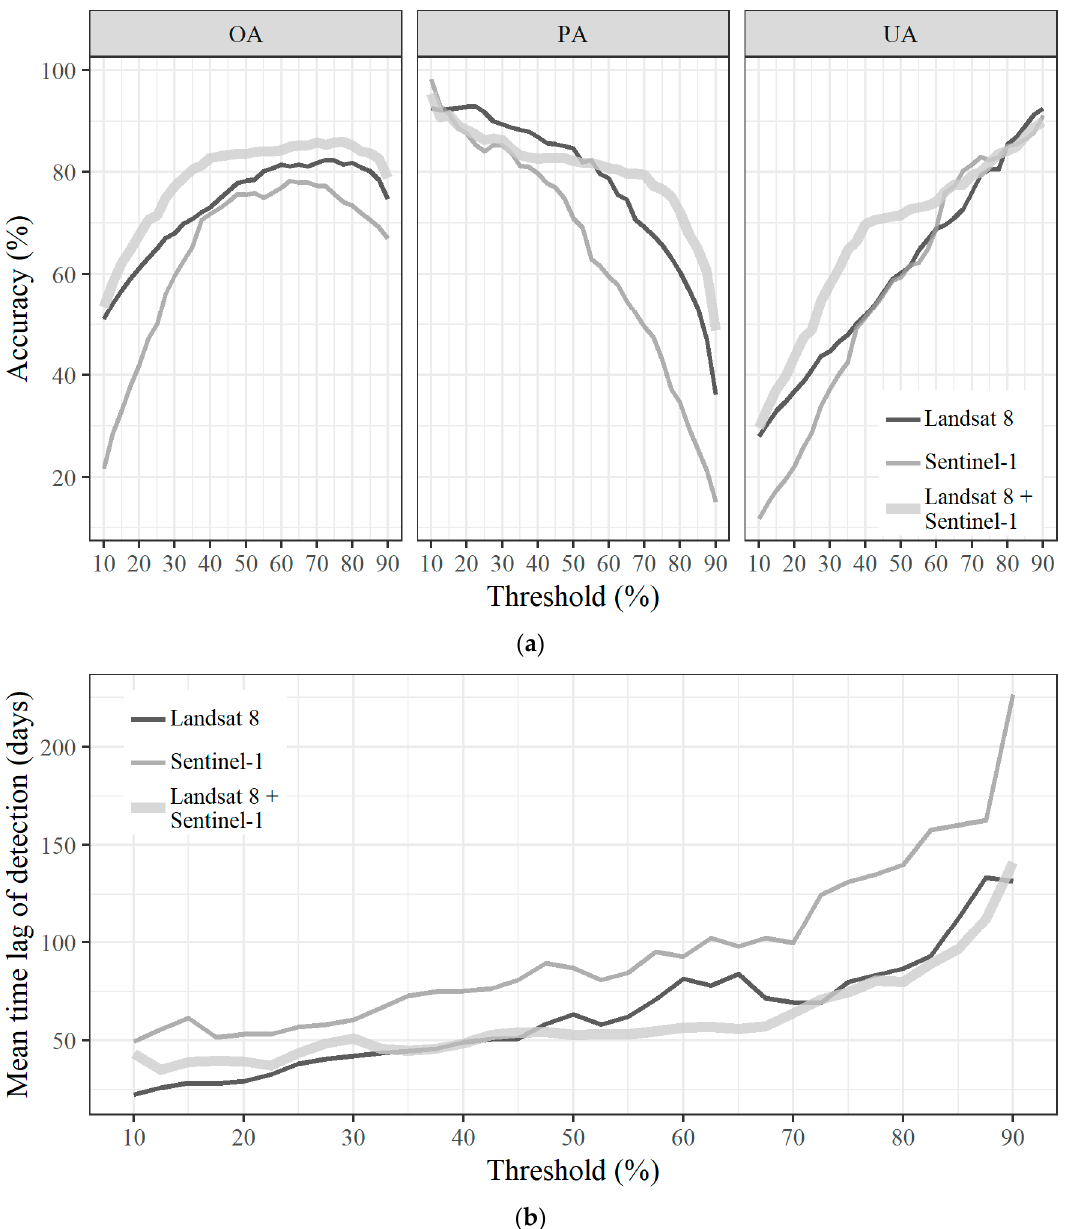
Figure 10. Accuracy of disturbance detection for thresholds from 10–90% in terms of ( a ) OA and PA/UA of disturbance and ( b ) mean time lag of detection using only Landsat 8, only Sentinel-1 and combining Landsat 8 and Sentinel-1.